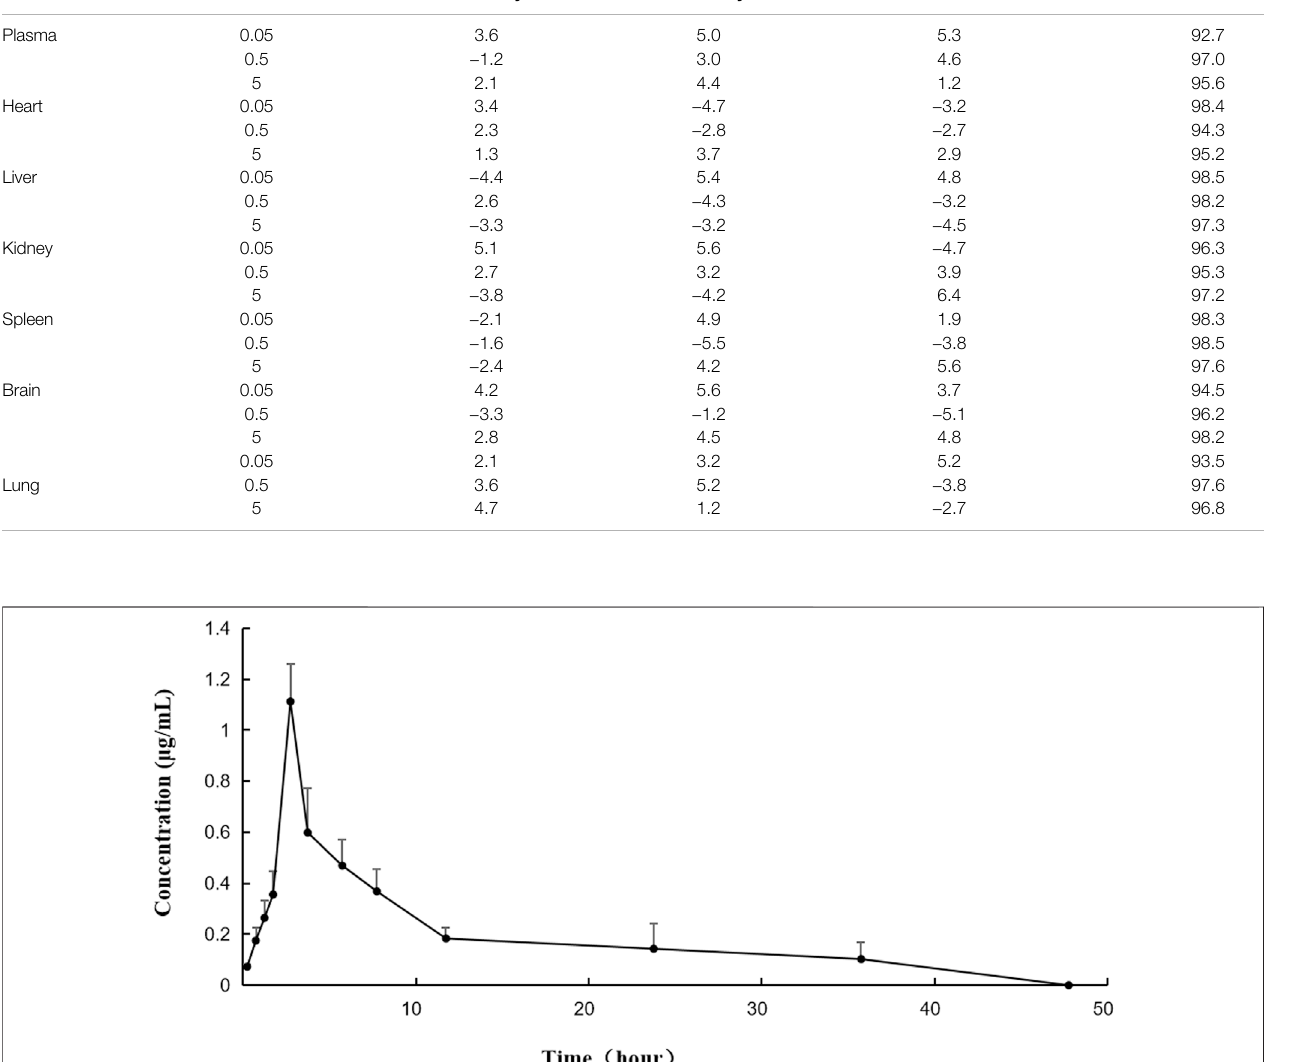
Frontiers in Pharmacology |